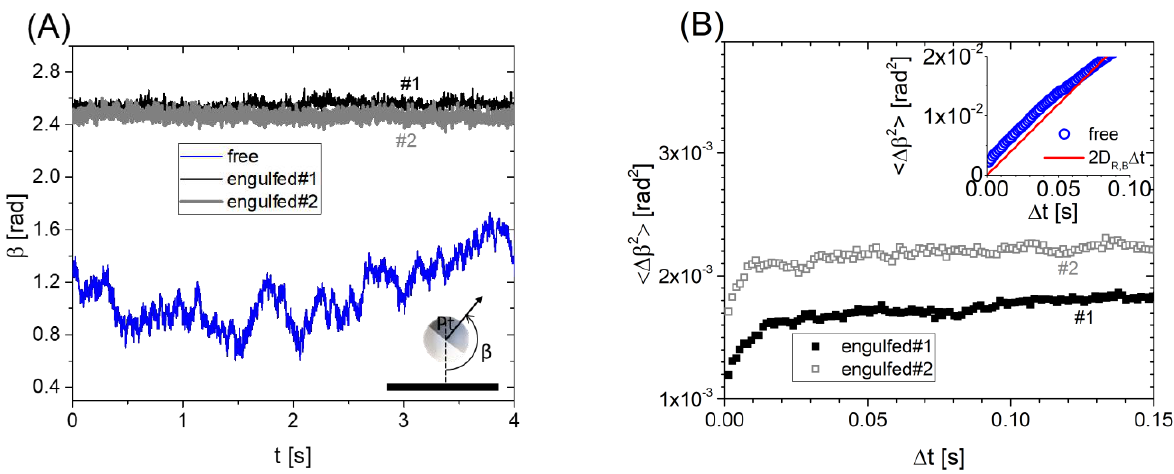
Figure 6. ( A ) Out-of-plane particle orientation angle β as a function of time t for a free isolated Janus colloid and two partially engulfed Janus colloids by GUVs. The sketch in the inset shows the definition of β . ( B ) Mean squared angular displacements < ∆ β 2 > as a function of the lag time ∆ t corresponding to the data shown in ( A ). In the inset, < ∆ β 2 > data for a “free” colloid are compared with the Brownian rotational dynamics prediction: < ∆ β 2 > = 2 D R,B ∆ t